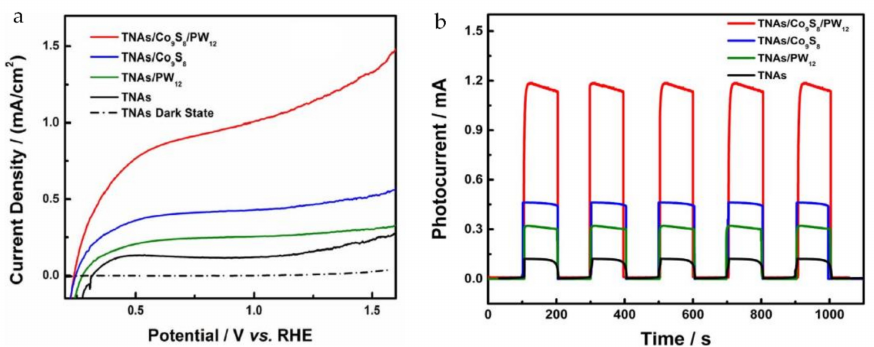
Figure 13. ( a ) LSV of TNAs, TNAs/PW 12 , TNAs/Co 9 S 8 , and TNAs/Co 9 S 8 /PW 12 the composite photoelectrodes in 0.5 M Na 2 SO 4 Aqueous solution. ( b ) The Photocurrent responses of TNAs, TNAs/PW 12 , TNAs/Co 9 S 8 , and TNAs/Co 9 S 8 /PW 12 composite photoanodes